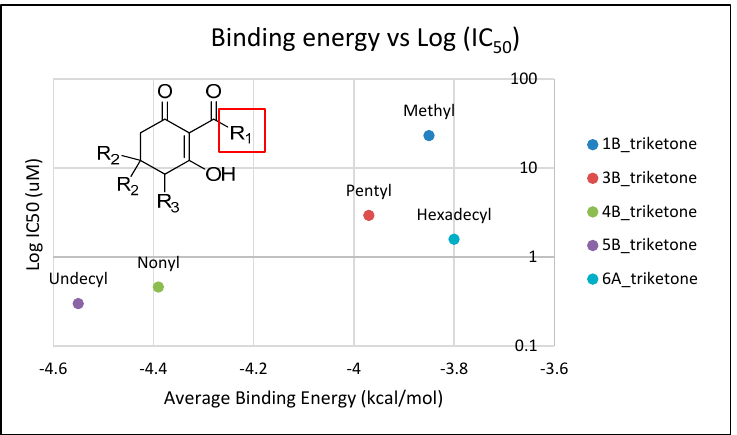
Figure 6. The relationship of binding energy and the log I 50 of a selection of 2-acyl-cyclohexane-1,3- diones with simple aliphatic side chains (R 1 subgroup; indicated by a red square). Another trend indicated by docking studies is that the addition of methyl moieties to the base ring structure at the positions indicated by R 2 negatively impacts I 50 app values.